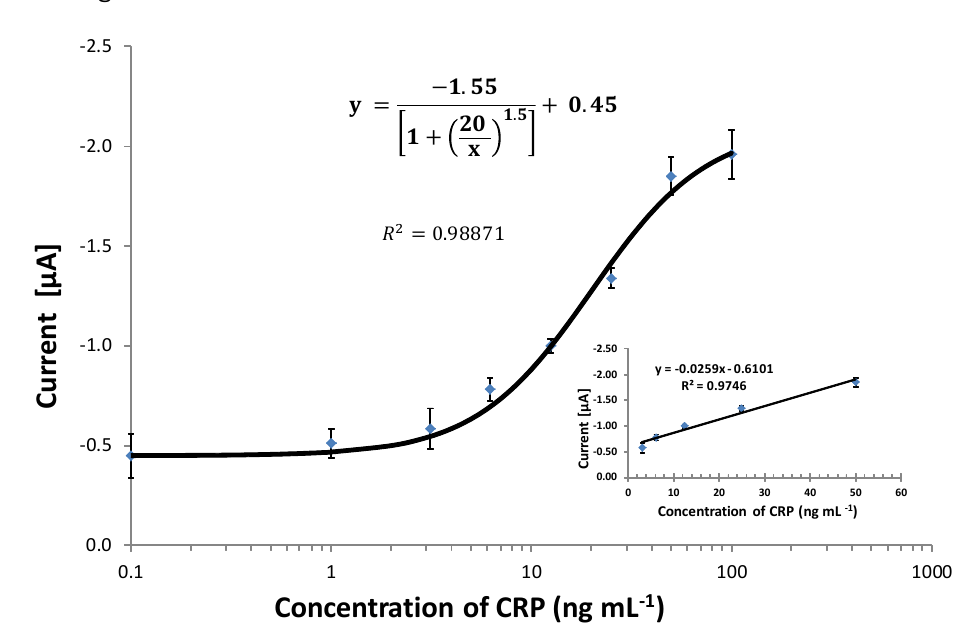
Figure 4. The optimised logarithmic standard curve for the C-reactive protein assay in spiked serum samples on the screen-printed gold electrodes (SPGEs). Electrodes were coated with coating antibody (60 µg·mL −1 ) incubated for 2 h at 37 °C, washed and blocked (10% milk protein). Known concentrations of CRP antigen in serum were premixed with the detection antibody to give appropriate final concentrations. The premixed solution was incubated for 1 h on a rotator. A 20-µL sample was then deposited on the blocked working electrodes and incubated for 1 h. The electrodes were washed, the substrate added and chronoamperometry measurements conducted at a −200 mV potential run for 200 s using Autolab. CV = 9.8%; the bars represent the standard error of the means (n = 4). LOD = 2.6 ng·mL −1 .